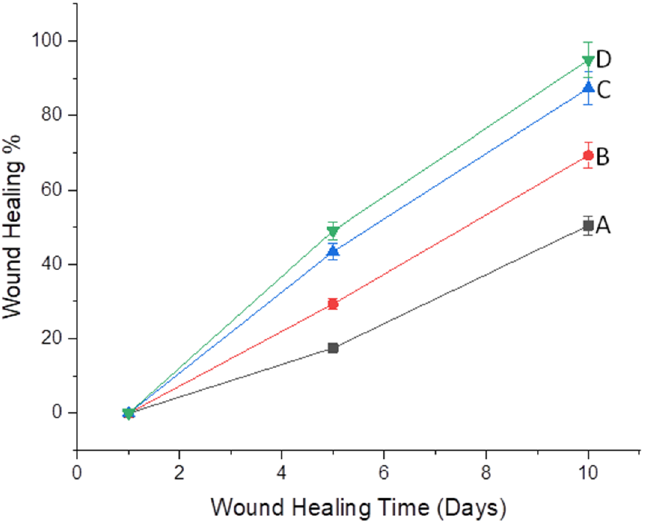
Figure 9. Percentage wound-healing of untreated group ( A ), treated with blank ( B ), treated with CEO-encapsulated NFs ( C ) and treated with commercial product ( D ). Table 4. P ercentage wound contraction of wounded skin treated with NFs on different days.